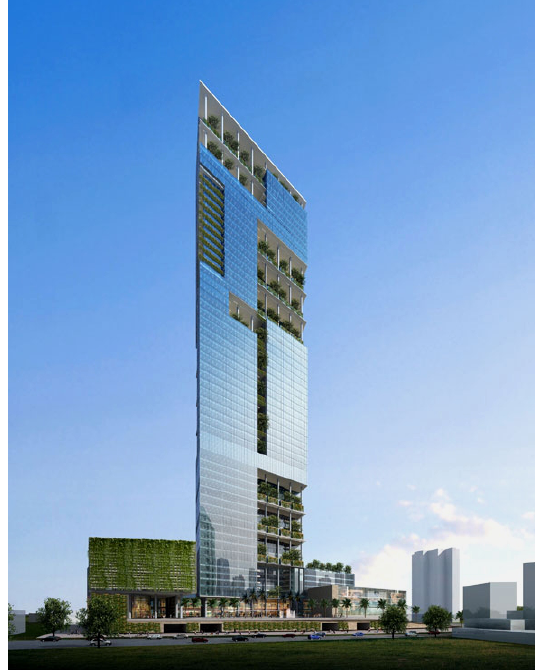
Figure 12. Elphinstone Mills (courtesy of Adrian Smith + Gordon Gill